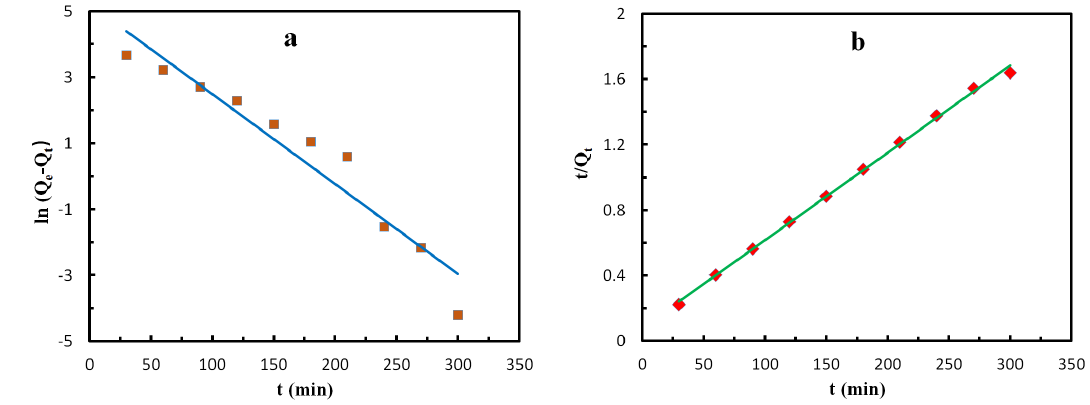
Figure 12. Fitting plots of the PFO ( a ) and PSO ( b ) models in the MB adsorption process. Table 3. Calculated kinetic constants of the PFO and PSO models in the MB adsorption process.